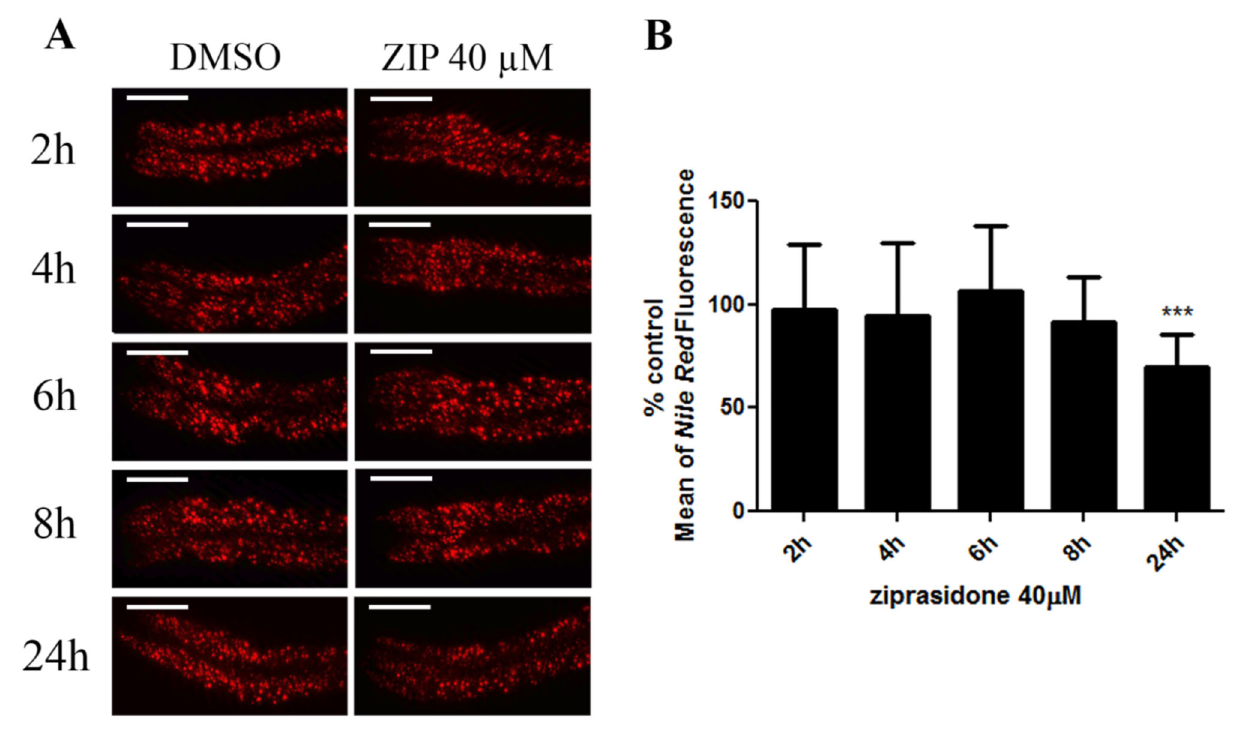
Figure 3. Ziprasidone activity-time curve on Nile red fluorescence in Caenorhabditis elegans . (A) Nile Red fluorescence in wild-type adult worms (N2) after Ziprasidone (40 µM) treatment; (B) Activity-time curve for 2, 4, 6, 8 and 24 hours. At the image acquisition time, all worms were in the same larval stage (adult). Data were normalized in percentage of each time respective control. Just in 24h hours, Ziprasidone significantly reduced the Nile Red fluorescence (***p<0.001, by ANOVA with Bonferroni correction for post hoc multiple comparisons, mean, SD,